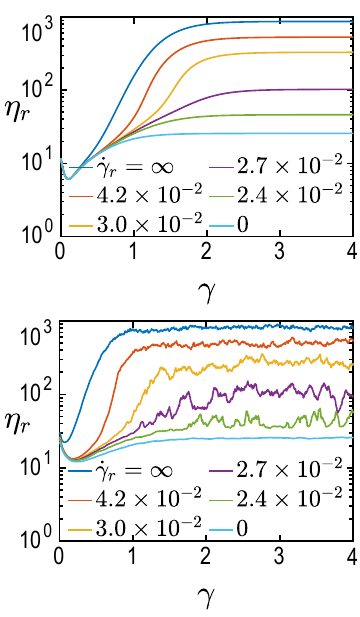
Figure 2. Upper panel: reduced viscosity as a function of strain after flow reversal of simple shear for various strain rates, from the constitutive model of [2]. Lower panel: corresponding data from particle-based simulations. See [2] for further